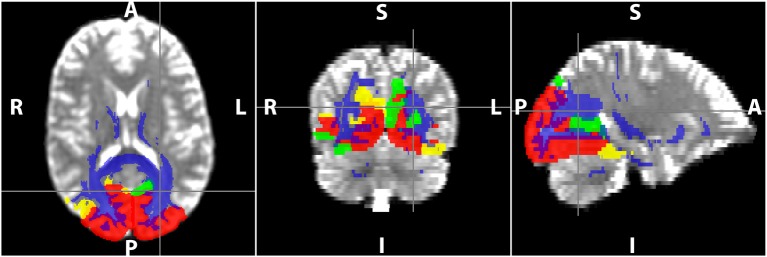
Delineation of WM tracts using TrackVis in the visual resting-state network (RSN). The red, yellow, and green regions are the occipital, parietal, and temporal regions of the visual RSN, and the voxels in blue represent the WM voxels of all the tracts that are part of the RSN.